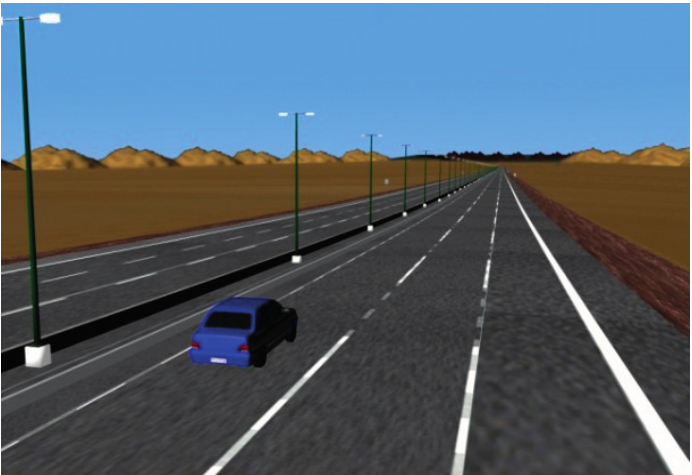
Figure 3. A view of the designed path